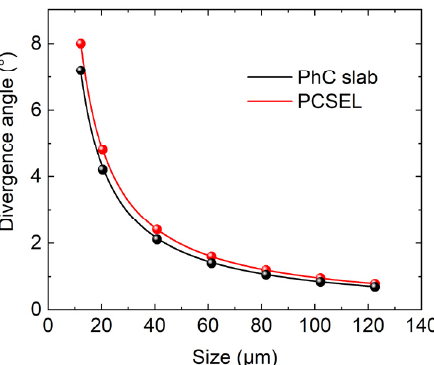
Figure 5. Divergence angle versus the size of PhC cavity for PhC slab and PCSEL, respectively. The air filling factor and hole depth are kept as 20% and 160 nm. air filling factor and hole depth are kept as 20% and 160